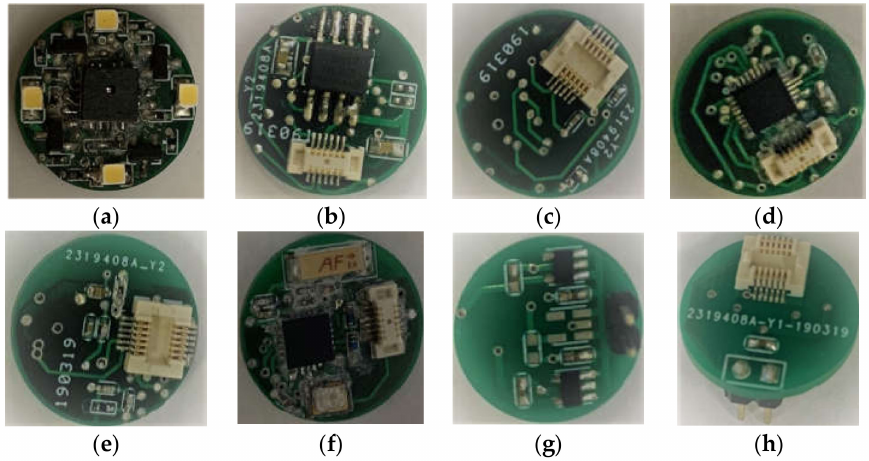
Figure 4. Illumination with spectral sensor: ( a ) top view; ( b ) bottom view. (ii) Control / processing unit: ( c ) top view; ( d ) bottom view. (iii) Telemetry unit: ( e ) top view; ( f ) bottom view. (iv) Power unit: ( g ) top view; ( h ) bottom